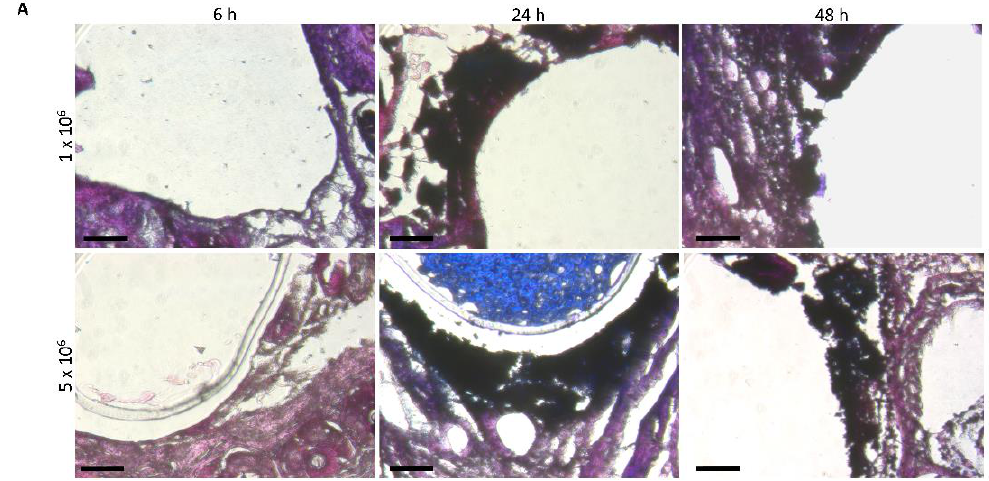
Figure 3. Local endothelium damage originating from the infected implants. ( A ) Purulent secretions at the implantation site after 48 h with 5 × 10 6 CFU (colony forming units) infected implant. ( B ) Histological staining with Masson Trichrome after 24 h, bars 50 µm. Gene expression of ( C ) vascular endothelial growth factor A (VEGF) and ( D ) Intercellular Adhesion Molecule 1 (ICAM) after 6 h, 24 h and 48 h, *: p < 0.05.